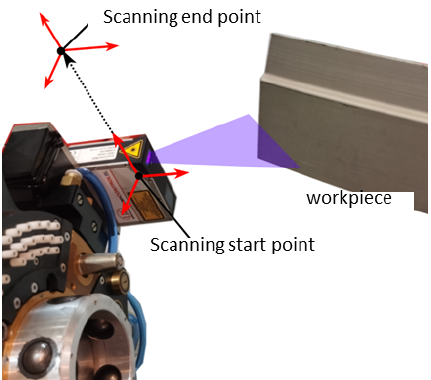
Figure 6. The installation of a manipulator and a